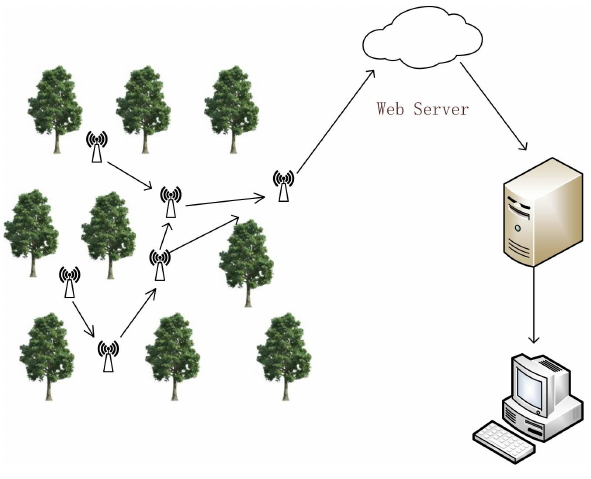
Figure 7. LoRa equipments deployed in